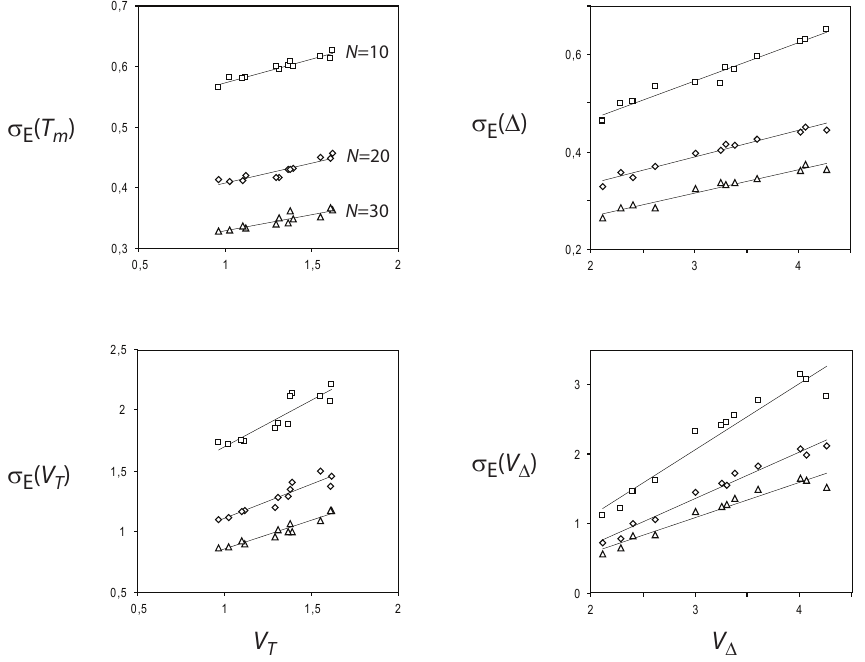
Fig. 7. Results of experiment 6. Left panels: Linear relationships between T m and V T standard errors obtained from MoCo versus V T in 12 time series modified from the Puerto Chicama time series. Right panels: Linear relationships between 1 and V 1 standard errors obtained from MoCo versus V 1 . For every variable, a least-square linear correlation was obtained for reconstructions using 10 shells (squares), 20 shells (diamonds), and 30 shells